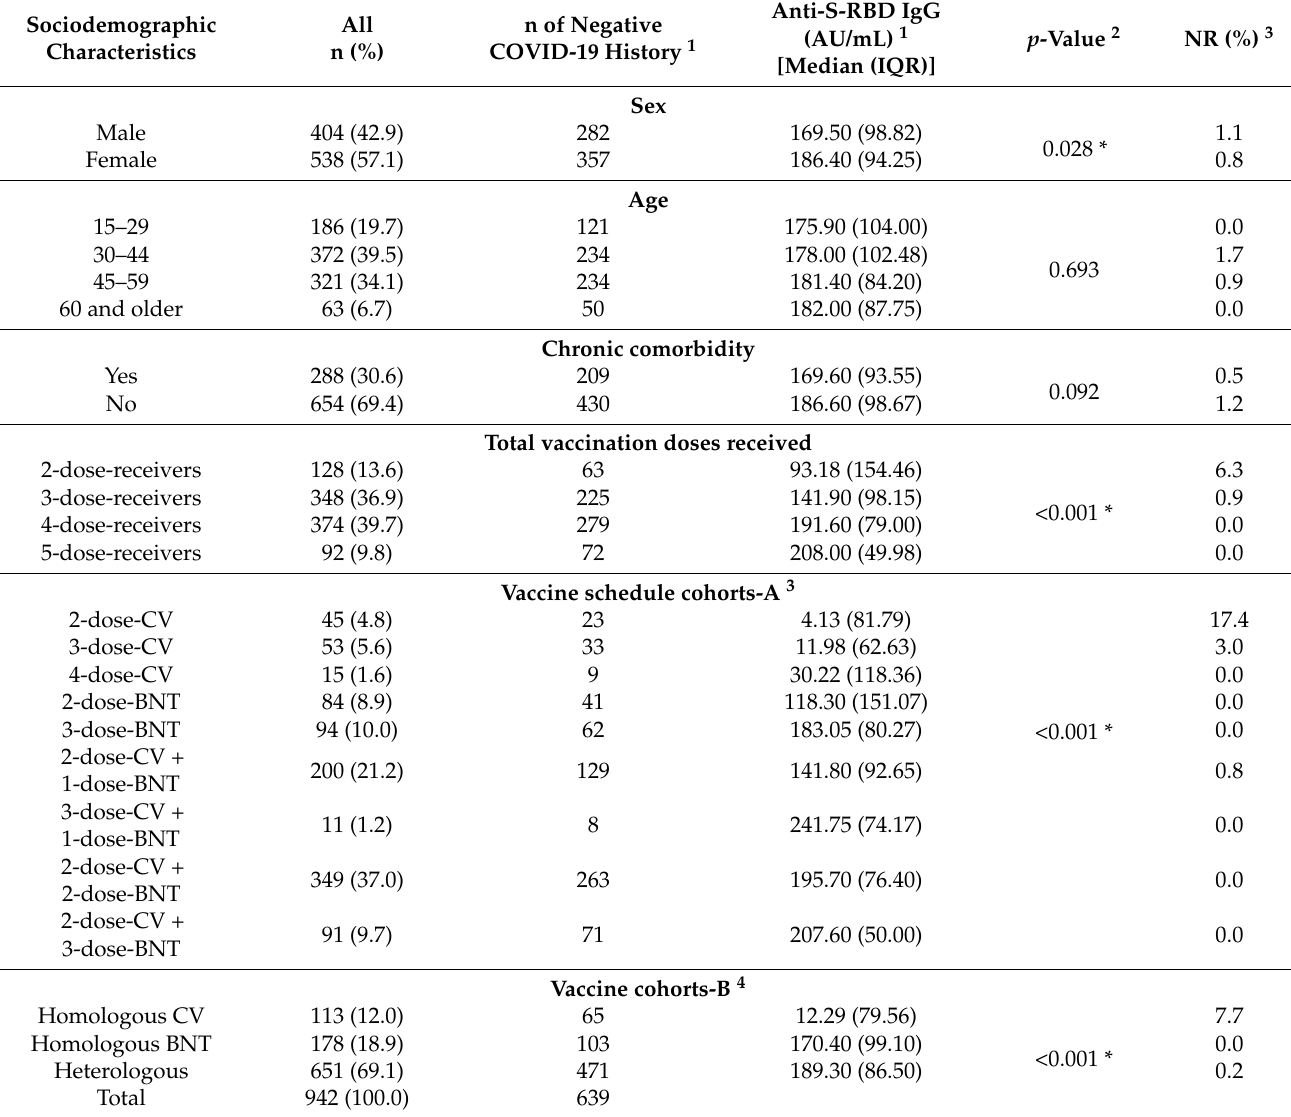
Table 1. Anti-S-RBD levels at month-12 by sociodemographic characteristics and vaccine